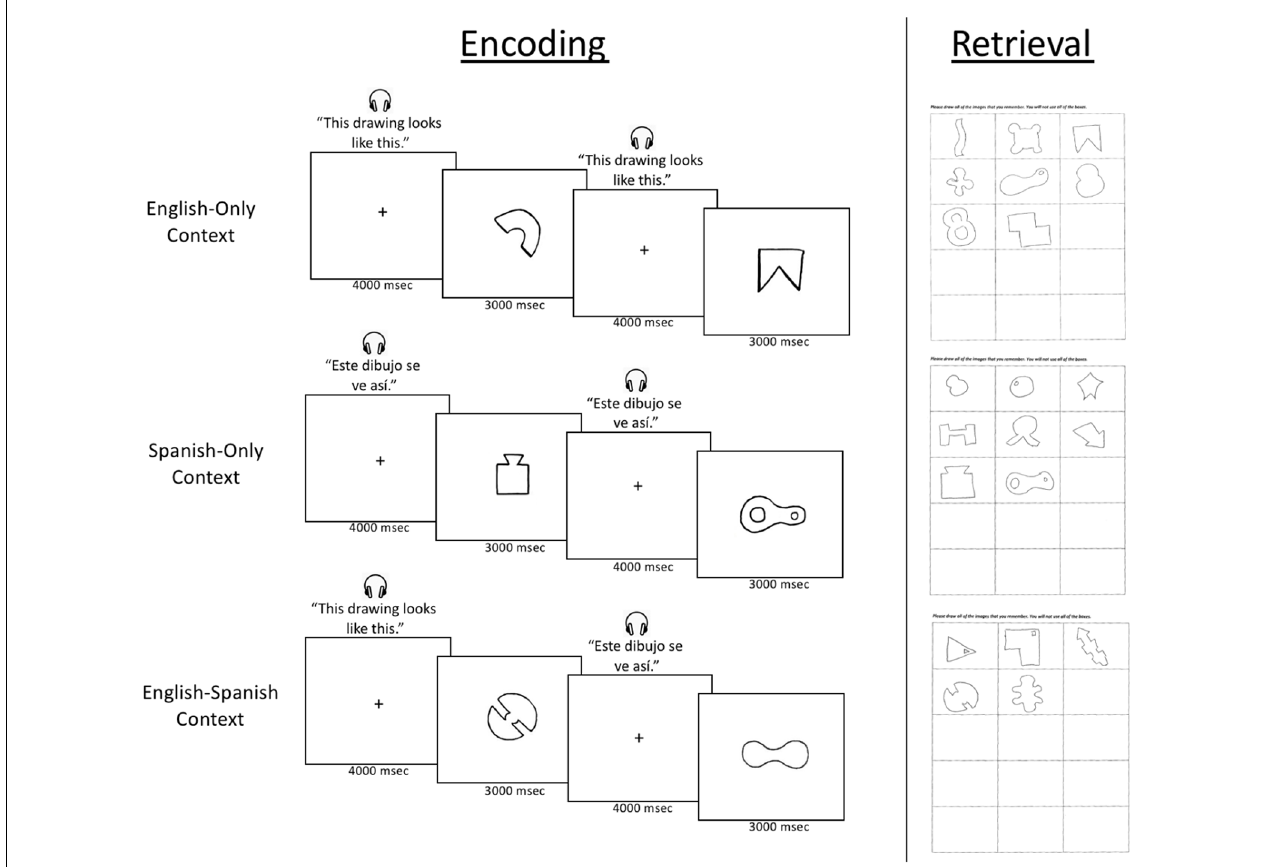
FIGURE 2 | The encoding and retrieval components of the memory test. The left side depicts the encoding procedure, in which participants viewed a series of novel shapes (in an English-Only, Spanish-Only, or English-Spanish language context). The right side depicts the retrieval procedure, in which participants drew all of the novel shapes they remembered seeing in the preceding encoding procedure. Note that the order of the three language contexts was counterbalanced across participants (as were the sets of